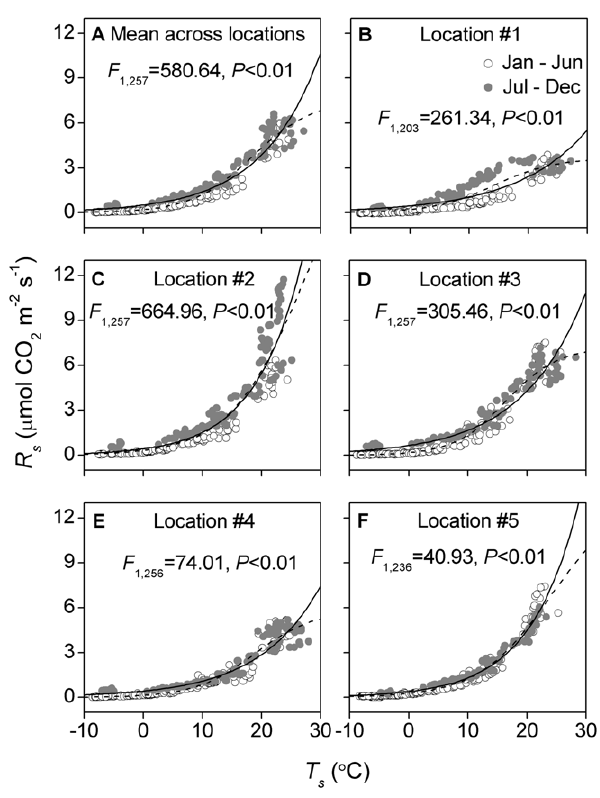
Figure 2. Relationships between daily mean soil respiration ( R s ) and soil temperature ( T s ). T s was monitored at 10-cm depth. Open circles are from January to June; closed circles are from July to December. The solid lines are fitted by a Q 10 model; the dashed lines are fitted by a logistic model. R s is significantly different between the first and second half of the year when the F -test gives P , 0.05.